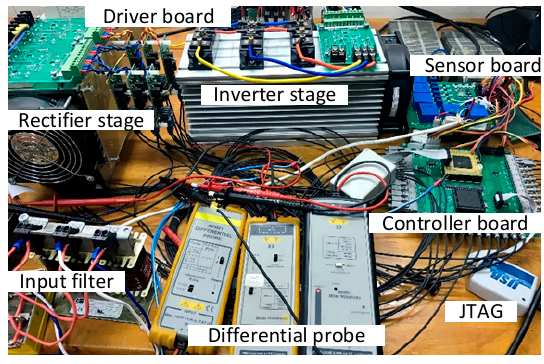
Figure 12. Experimental setup. Table 8. Summary of IGBT Module for the converter.